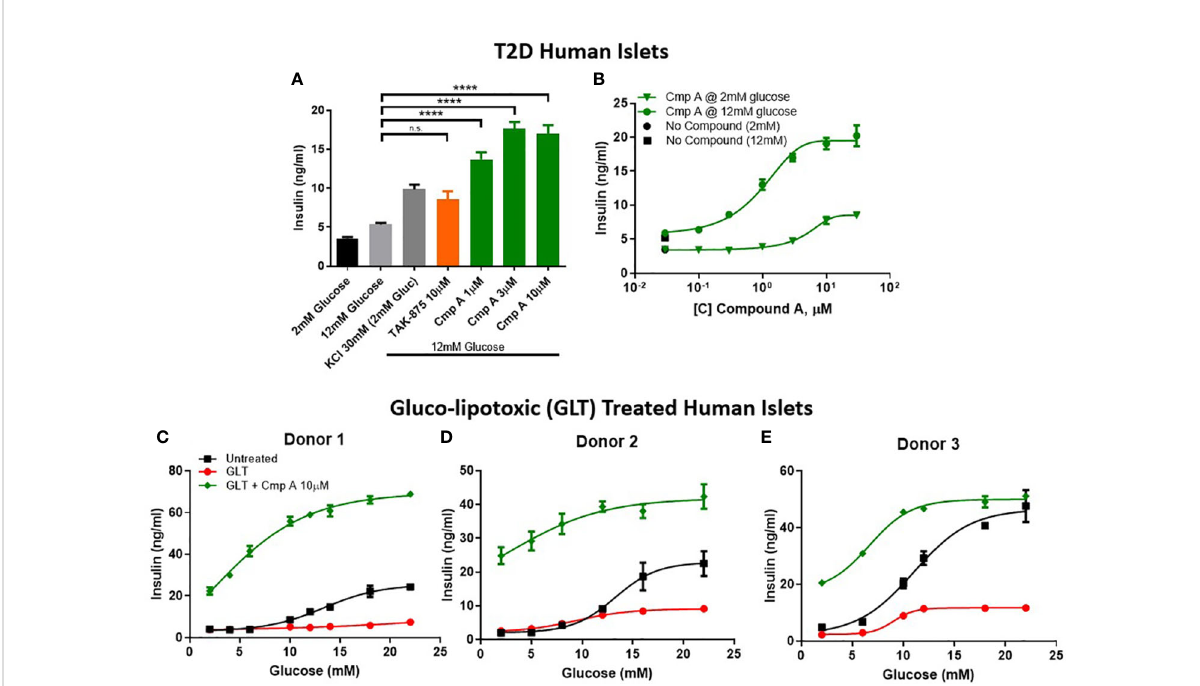
FIGURE 4 Insulin secretion from dysfunctional human islets. Diseased islets isolated from T2D donors (A) challenged in the presence of compounds at 12mM glucose (n=3). (B) Within one T2D donor, compound dose response curves in 12mM and 2mM glucose were measured. (C – E) To mimic b -cell dysfunction obsevered in T2D islets, healthy human islets were exposed to 48 hours of high glucose and lipid concentrations (gluco-lipo toxic GLT).-3 human donors were treated under GLT conditions then glucose responsive insulin secretion was measured in the presence or absence of compounds. **** p<0.0001 by 1-way ANOVA, n.s.,